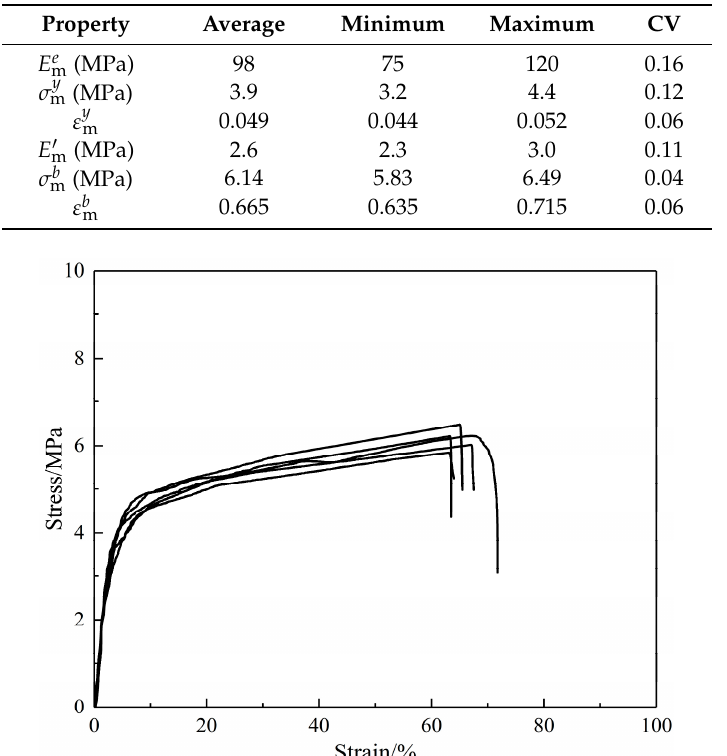
Table 2. Mechanical properties of SF/PCL nanofibrous mats.